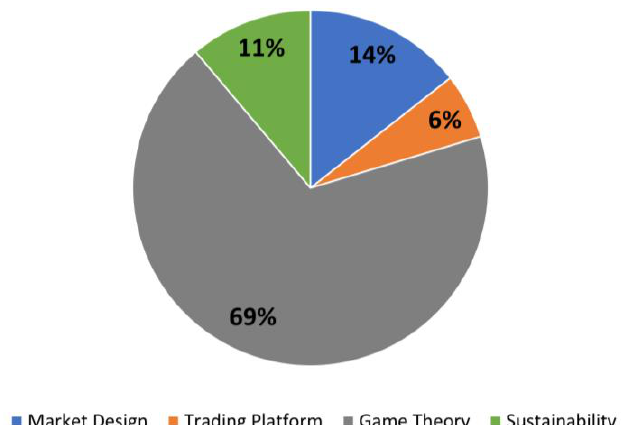
Figure 1. Percentage of documents addressing LEMs for P2P energy trading in the topics of SGs, MGs, and smart cities with focus on market design, trading platform, game theory, and sustainability.